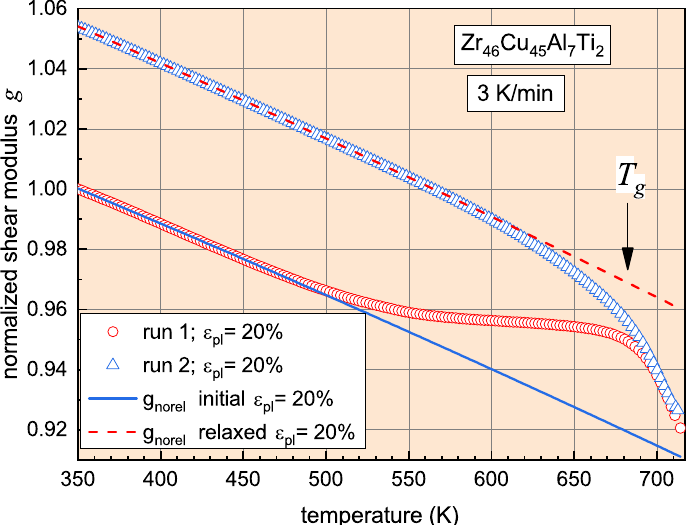
Figure 1. Temperature dependences of the normalized shear modulus g in the initial (run 1) and relaxed (run 2) states of a sample plastically predeformed by ε pl = 20%. The solid and dashed lines give temperature dependences of the sum of harmonic, anharmonic and electronic components denoted as g norel for the initial state (run 1) and after relaxation (run 2). The calorimetric glass transition temperature T g is indicated by the arrow. The error is less than symbols’